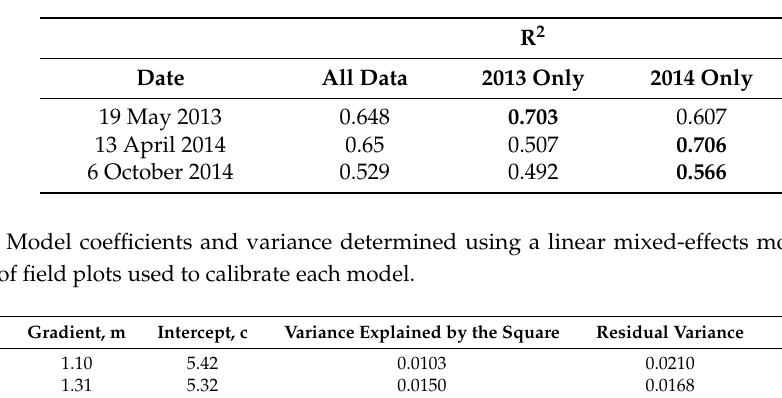
Table 4. Coefficient of determination, R 2 , for the regression between single date NDVI and in situ ANPP (g dry mass m − 2 year − 1 ) using in situ data from both years, 2013 only and 2014 only. Bold values show the best R 2 value achieved for each image.